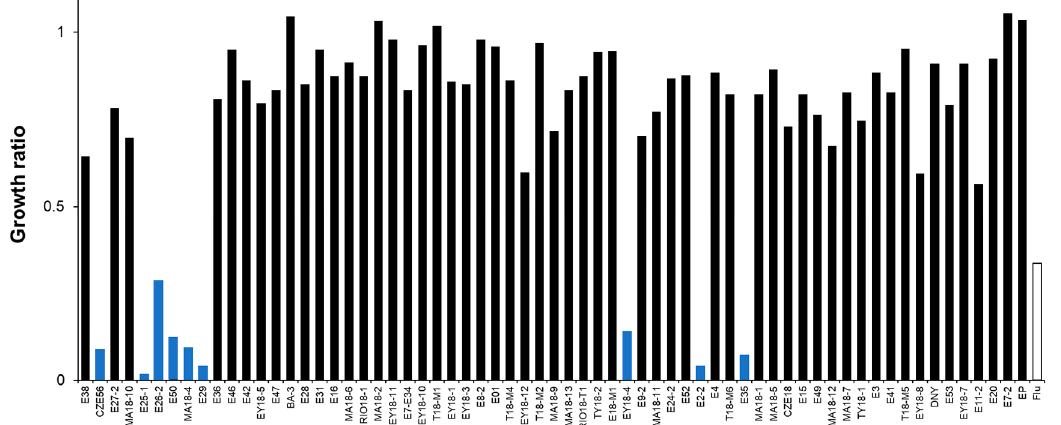
Figure 2. Susceptibility of C. glabrata to marine extracts from the Yucatan Peninsula. Growth was monitored after 48 h of incubation at 37 °C. Growth ratios were determined in comparison to control (untreated) cells. Fluconazole (a triazole antifungal) was used as a reference antifungal (16 µg/mL). Growth ratios below 0.5 indicate active extracts (blue bars).